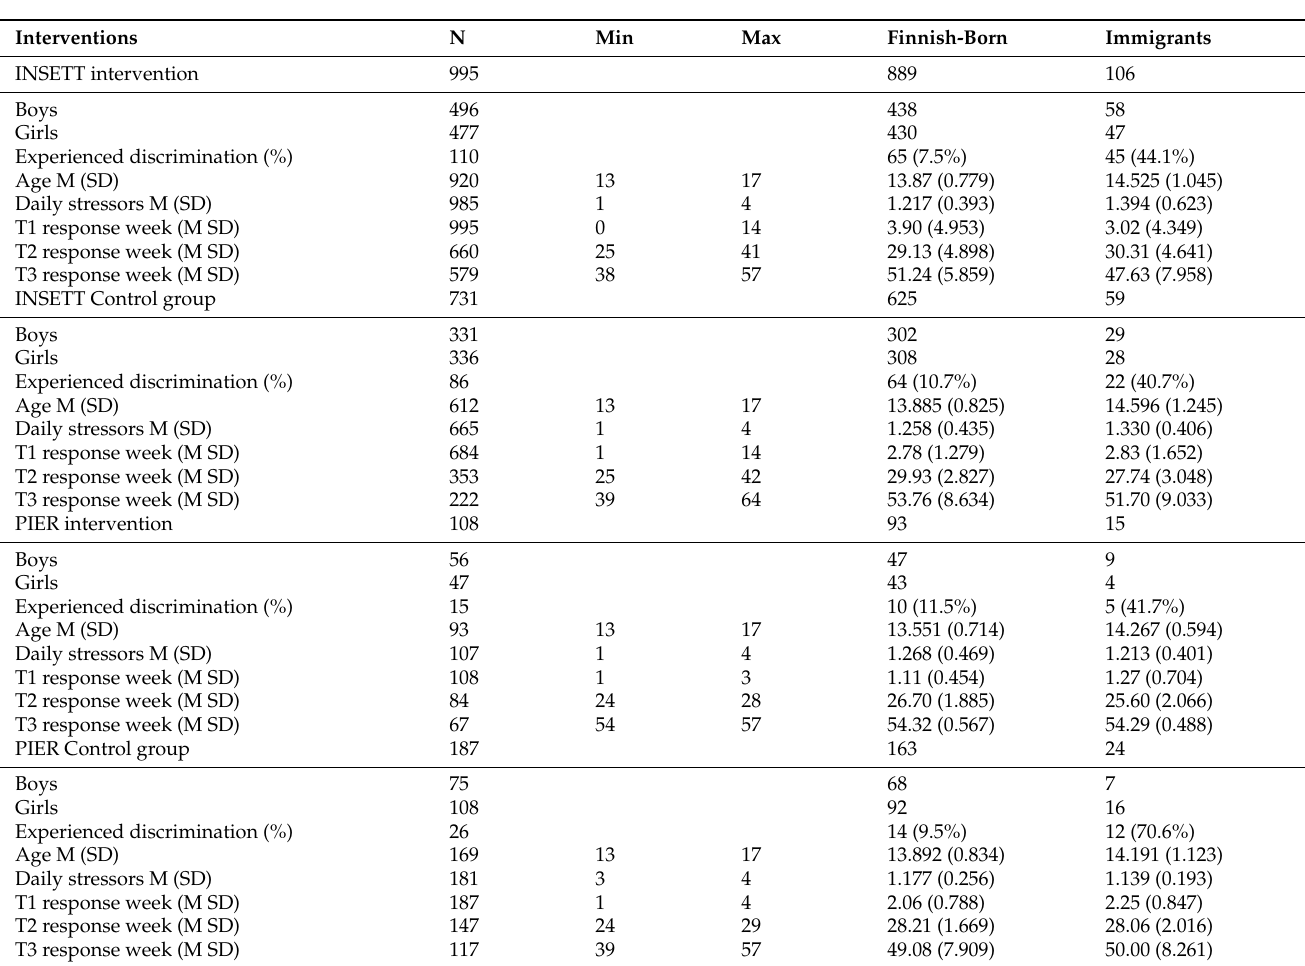
Table 2. Estimates for independent